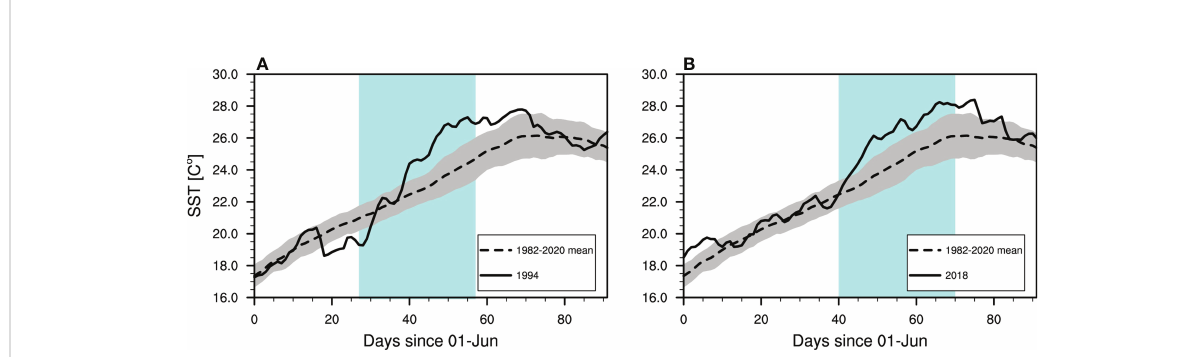
FIGURE 1 Time-series plots of daily mean sea surface temperature (solid), climatological mean (dashed), and interannual variability with one standard deviation (gray shading) around the Korean Peninsula (33.5 – 37.5° N, 124.0 – 131.0° E) for 1994 (A) and 2018 (B) , respectively. The daily climatological mean and standard deviation is calculated for 1982 – 2020. Colored areas represent the selected model periods for each